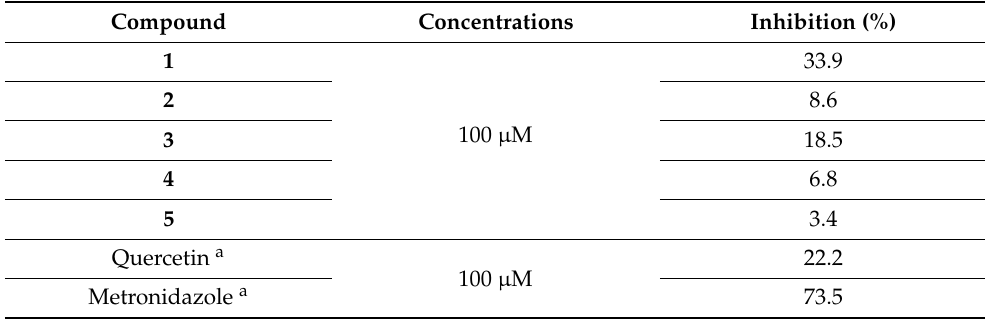
Table 2. Anti- H. pyroli activity of compounds 1 – 5